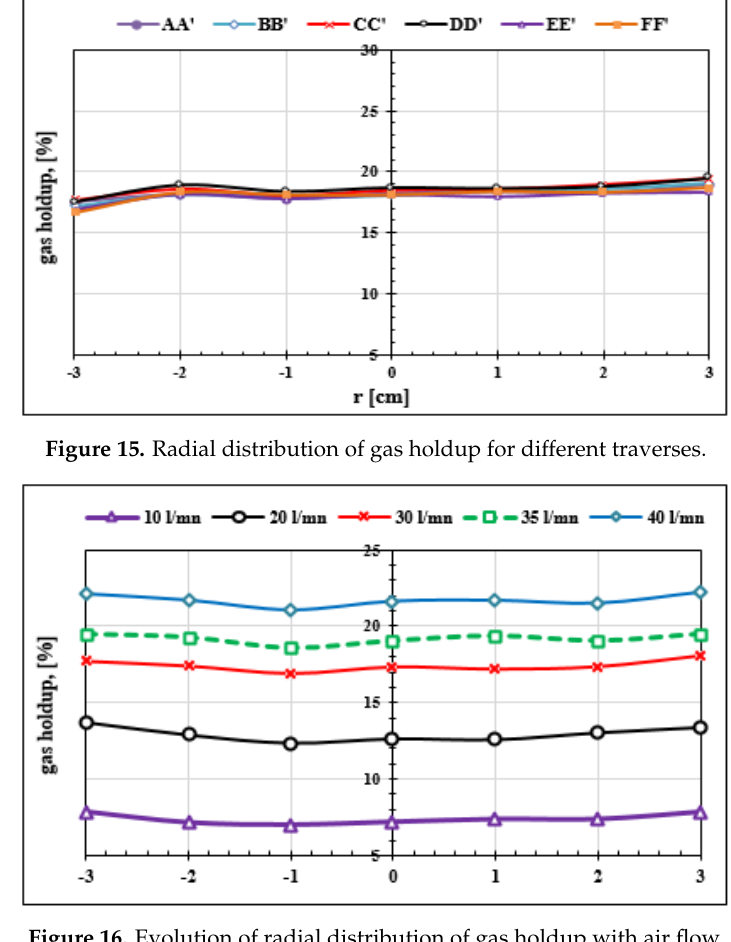
Figure 16. Evolution of radial distribution of gas holdup with air flow.